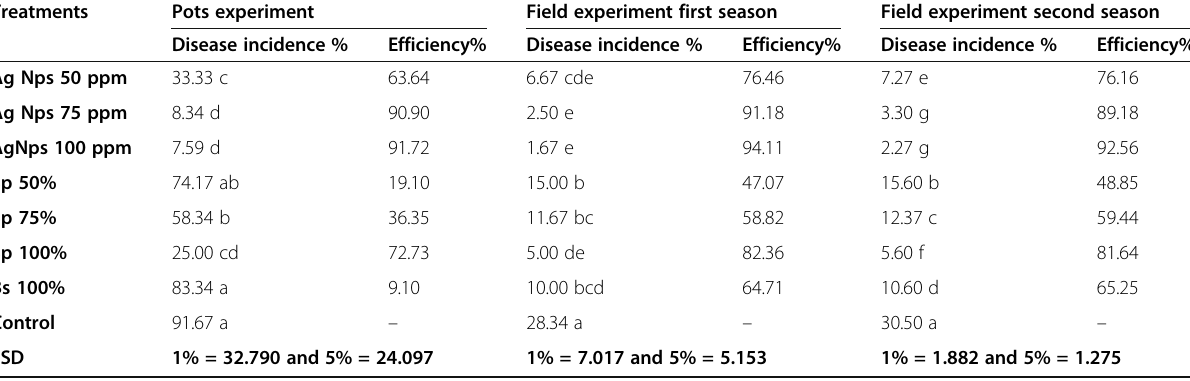
Table 3 Efficiency of the tested treatments against bacterial root rots in sugar-beet in pots and field at harvest Treatments Pots